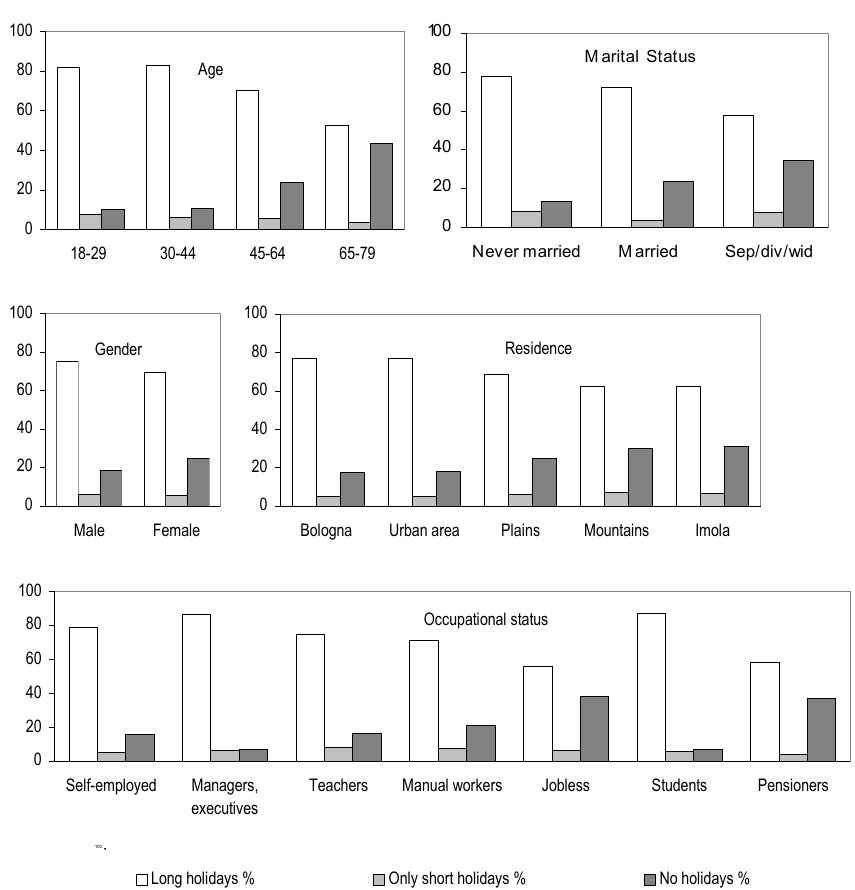
Figure 4 – Holiday frequencies and sociodemographic conditions during 2004.